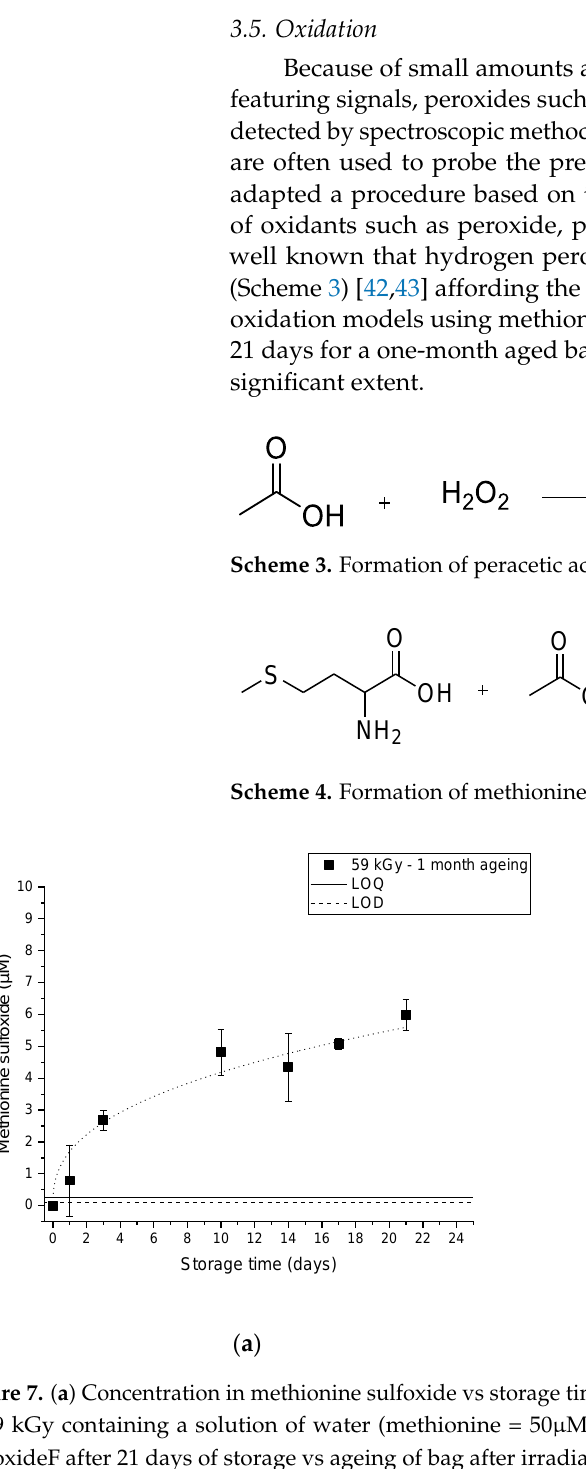
Scheme 3. Formation of peracetic acid .